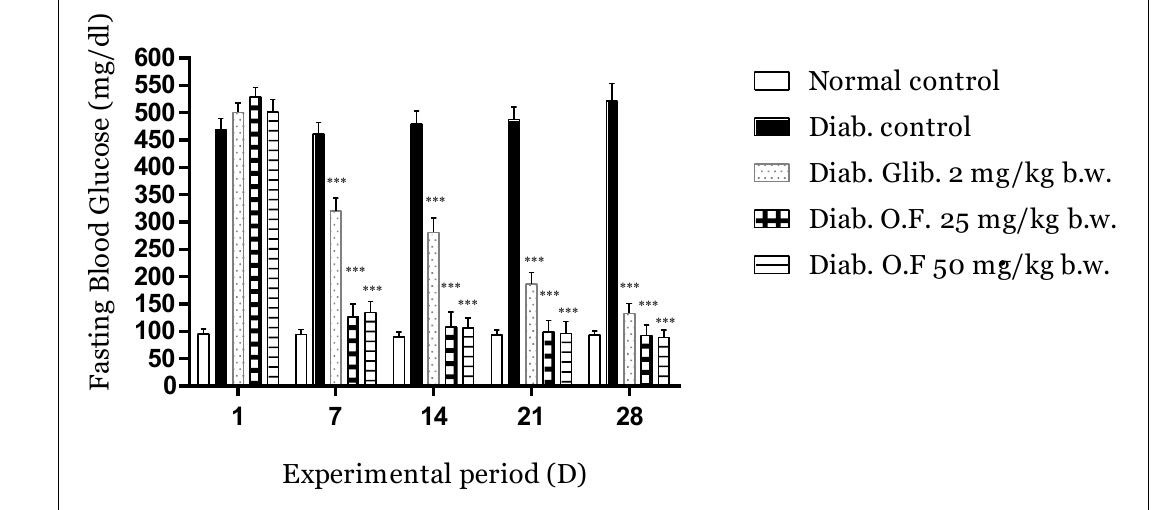
Figure 2. Effect of flavonoids on fasting blood glucose Alloxan-induced diabetic mice during the experimental period of 28 days. Values are expressed as mean ± SD ( n = 5 mice). *** p < 0.001 compared to diabetic control.